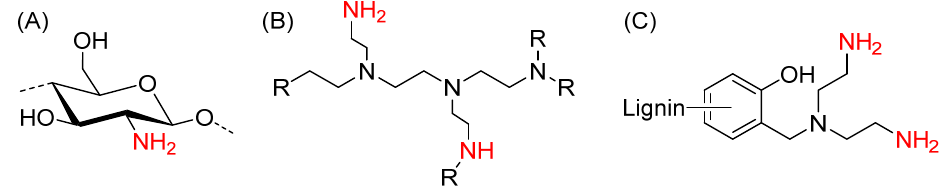
Figure 2. Polyamines used in this work for the cross-linking of keto-HPC: ( A ) chitosan, ( B ) (branched) PEI, and ( C ) Kraft lignin diethylamine (KL-DETA).